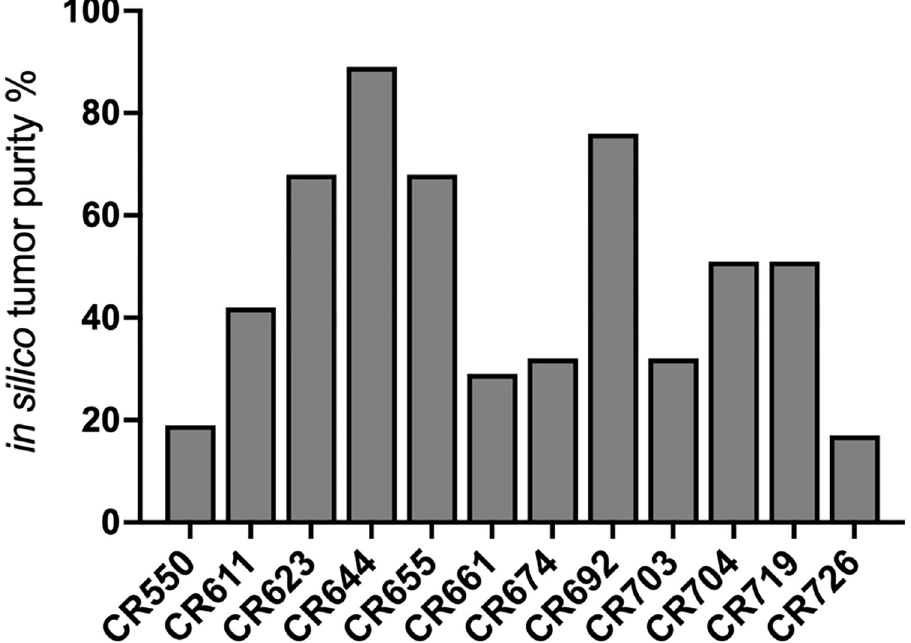
Fig 2. PureCN tumor purity assessment of CRCLM patient tumors from 12 patients using tumor only data. https://doi.org/10.1371/journal.pone.0271354.g002 PLOS ONE | https://doi.org/10.1371/journal.pone.0271354 April 6,